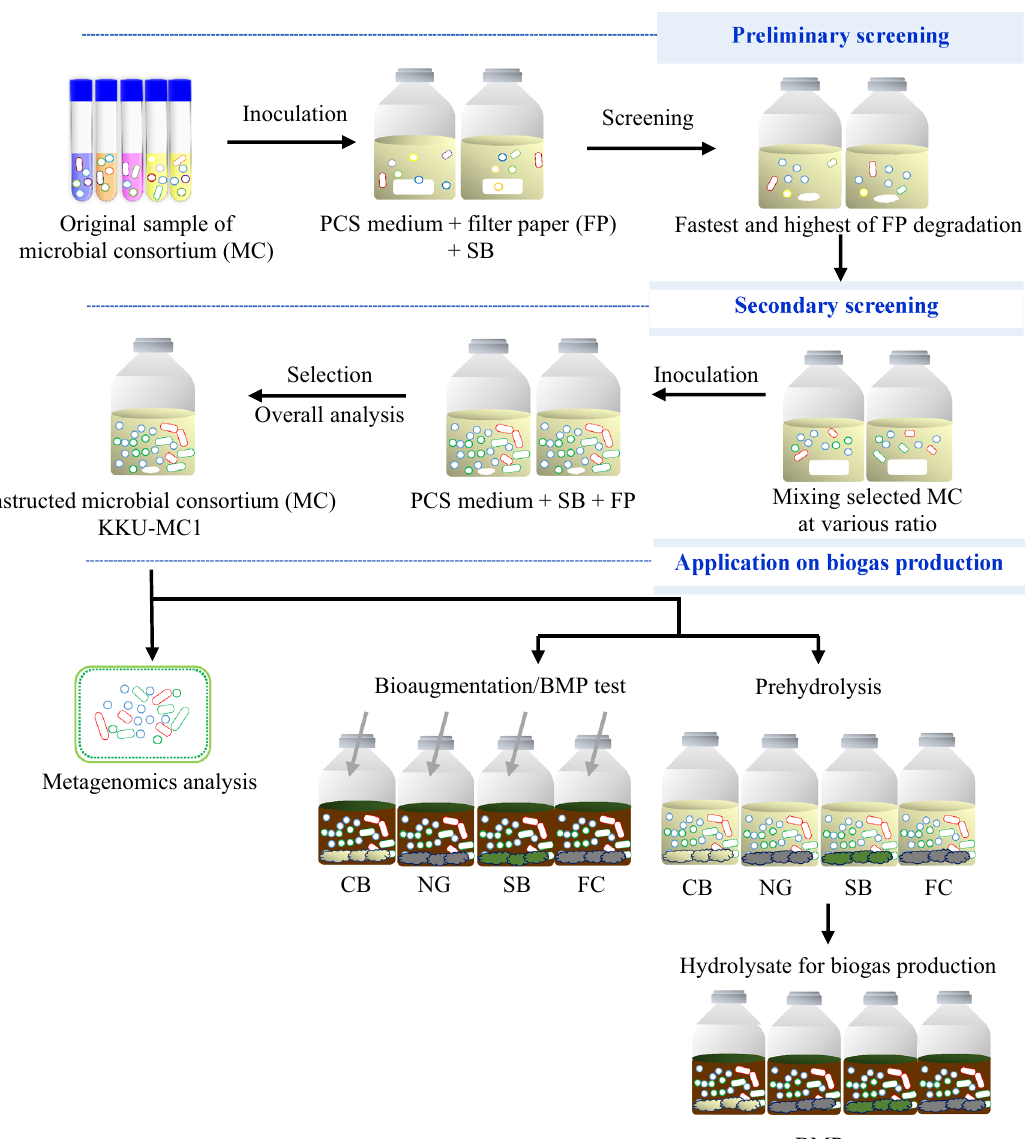
Figure 1. Flow chart of the experiments. CB Cassava bagasse, NG Napier grass, SB sugarcane bagasse, FC filter cake, BMP biochemical methane potential test, PCS peptone cellulose solution.